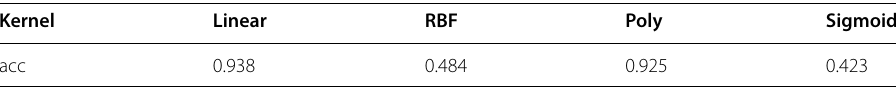
Table 1 Relationship between kernel and accuracy Kernel Linear RBF Poly Sigmoid acc 0.938